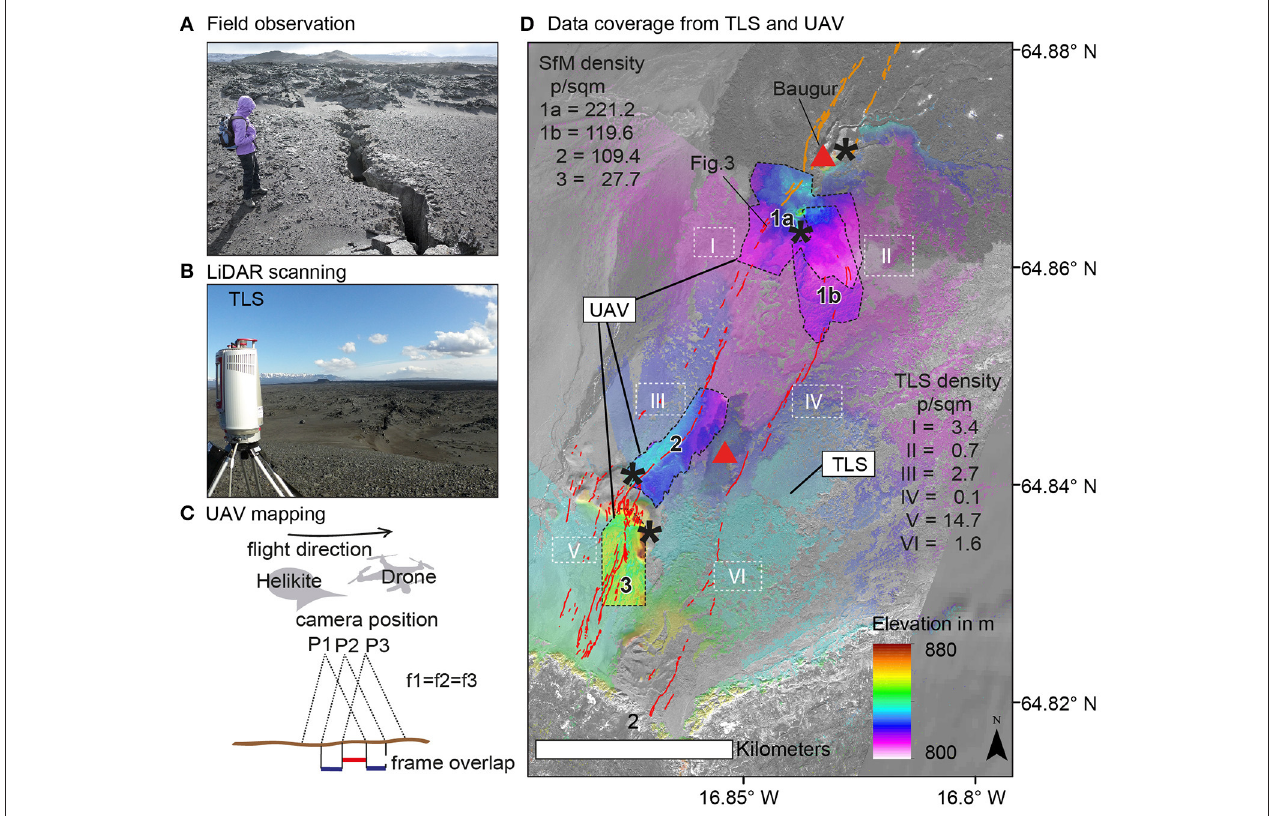
FIGURE 2 | Methods– (A) Field observations in August 2015. (B) LiDAR scanning was performed using a TLS device, a Riegl VZ-6000 instrument, with a scanning distance of up to 6 km. (C) Sketch of UAV data acquisition. We used either a balloon kite or drones, equipped with cameras, moving in loops over the ground and constantly acquiring photos. (D) Data coverage of the used acquisition techniques. The colored point cloud in the background shows the topographic data set acquired by TLS, with black stars depicting single scan positions spanning an area of almost 20km 2 . Colored point clouds with higher intensities are areas where UAV imaging data were acquired. Point densities (in points per square meter) are indicated. Red lines indicate fractures observed from our data. Orange lines indicate fractures buried by lava as observed by Hjartardottir et al. (2016).